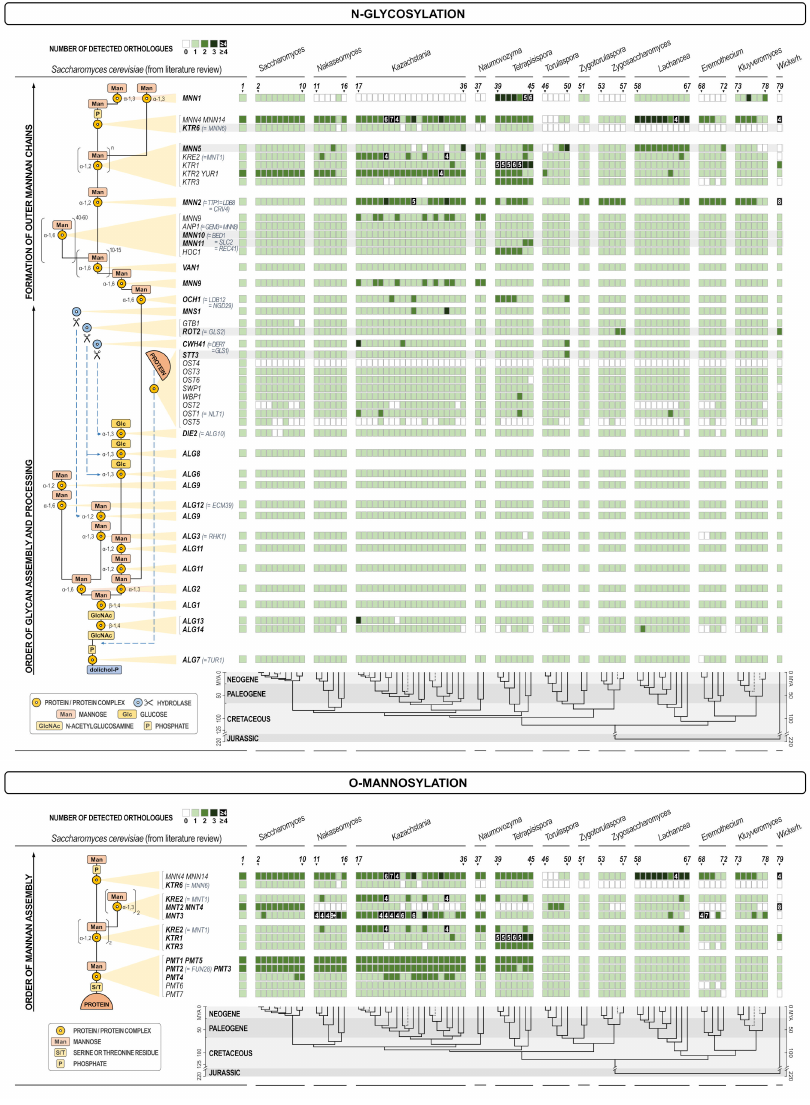
Figure 1. Heat map of orthologues of S. cerevisiae genes involved in protein glycosylation. Every gene is presented in one row, while every yeast is presented in one line. Compared yeasts are: 1. Saccharomyces (S.) cerevisiae in SGD; 2. S. cerevisiae re-annotated; S. cerevisiae var. boulardii ; 4. S. paradoxus ; 5. S. mikatae ; 6. S. jurei ; 7. S. kudriavzevii ; 8. S. arboricola ; 9. S. uvarum ; 10. S. eubayanus ; 11. Candida (C.) nivariensis ; 12. Nakaseomyces (Na.) delphensis ; 13. C. bracarensis ; 14. C. glabrata ; 15. Na. bacillisporus ; 16. C. castellii ; 17. Kazachstania (Ka.) solicola ; 18. Ka. aerobia ; 19. Ka. servazzii ; 20. Ka. unispora ; 21. Ka. siamensis ; 22. Ka. transvaalensis ; 23. Ka. yakushimaensis ; 24. Ka. taianensis ; 25. Ka. naganishii ; 26. Ka. telluris ; 27. Ka. bromeliacearum ; 28. Ka. intestinalis ; 29. Ka. martiniae ; 30. Ka. turicensis ; 31. Ka. saulgeensis ; 32. Ka. kunashirensis ; 33. Ka. spencerorum ; 34. Ka. rosinii ; 35. Ka. africana ; 36. Ka. viticola ; 37. Naumovozyma (Nau.) dairenensis ; 38. Nau. castellii ; 39. Tetrapisispora (Te.) namnaonensis ; 40. Te. fleetii ; 41. Te. phaffii ; 42. Te. iriomotensis ; 43. Vanderwaltozyma polyspora ; 44. Te. blattae ; 45. Yueomyces sinensis ; 46. Torulaspora (To.) franciscae ; 47. To. pretoriensis ; 48. To. delbrueckii ; 49. To. maleeae ; 50. To. microellipsoides ; 51. Zygotorulaspora (Zyt.) florentina ; 52. Zyt. mrakii ; 53. Zygosaccharomyces (Zys.) bisporus ; 54. Zys. bailii ; 55. Zys. kombuchaensis ; 56. Zys. mellis ; 57. Zys. rouxii ; 58. Lachancea (L.) lanzarotensis ; 59. L. meyersii ; 60. L. dasiensis ; 61. L. nothofagi ; 62. L. quebecensis ; 63. L. thermotolerans 64. L. waltii ; 65. L. mirantina ; 66. L. fermentati ; 67. L. kluyveri ; 68. Eremothecium (E.) gossypii ; 69. Ashbya aceri ; 70. E. cymbalariae ; 71. E. coryli ; 72. E. sinecaudum ; 73. Kluyveromyces (Kl.) lactis ; 74. Kl. dobzhanskii ; 75. Kl. marxianus ; 76. Kl. wickerhamii ; 77. Kl. nonfermentans ; 78. Kl. aestuarii ; 79. Wickerhamomyces anomalus . The scheme of the cellular process with the site in which certain gene is involved is shown on the left. The intensity of the color of every square is proportional to the number of orthologues found as depicted in the inset legend. White square means no orthologue has been found. The lower part of the figure presents the evolutionary chronogram of each species. Genes coding for catalytic subunits are presented in bold and have a grey background if they are parts of a bigger